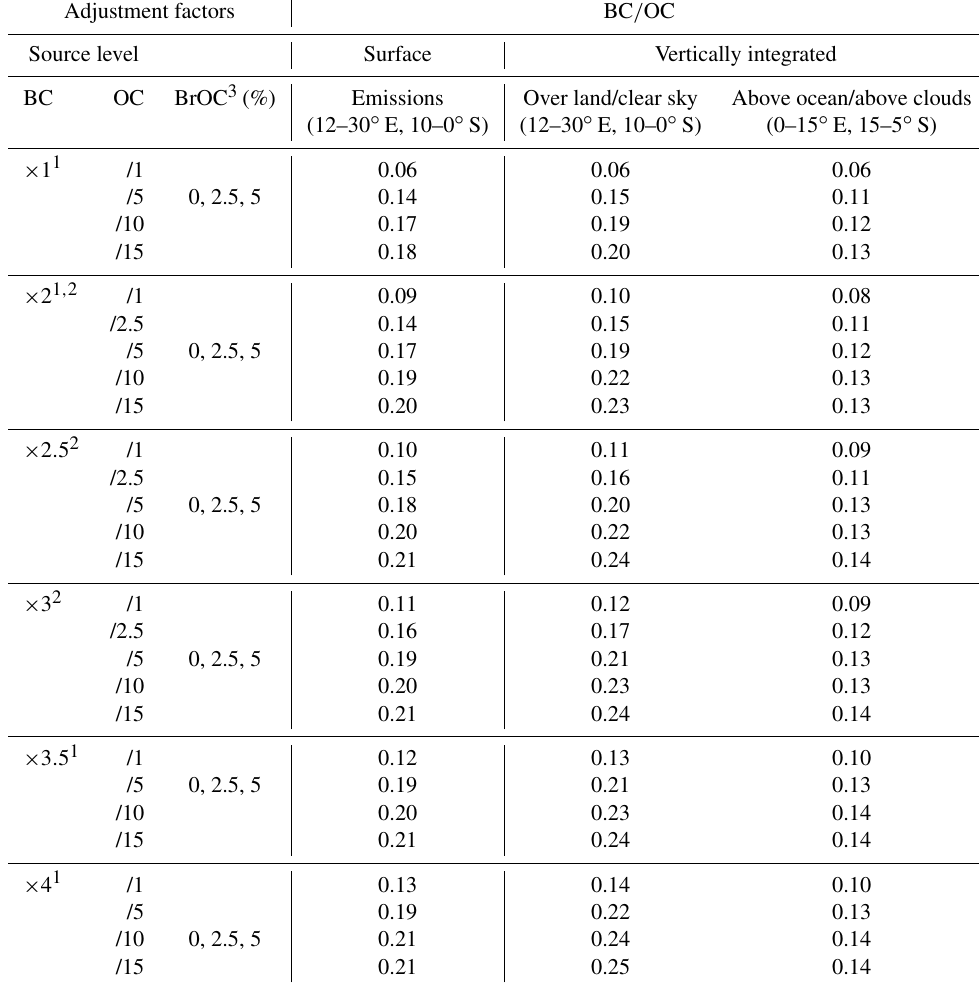
Table 4. Table of numerical experiments performed with the WRF-Chem partially constrained configuration to test the impact of a range of organic carbon (OC), black carbon (BC) and brown carbon (BrOC) proportions on simulated biomass burning aerosols